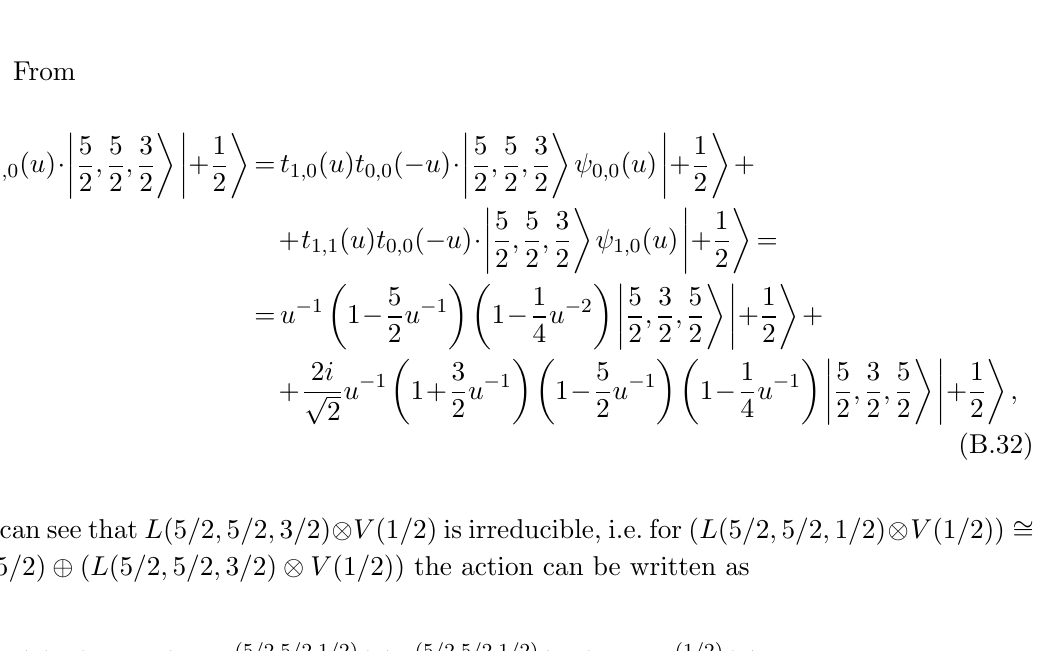
Table 8 . The states of L (5 = 2 ; 5 = 2 ; 3 = 2) (cid:10) V (1 =